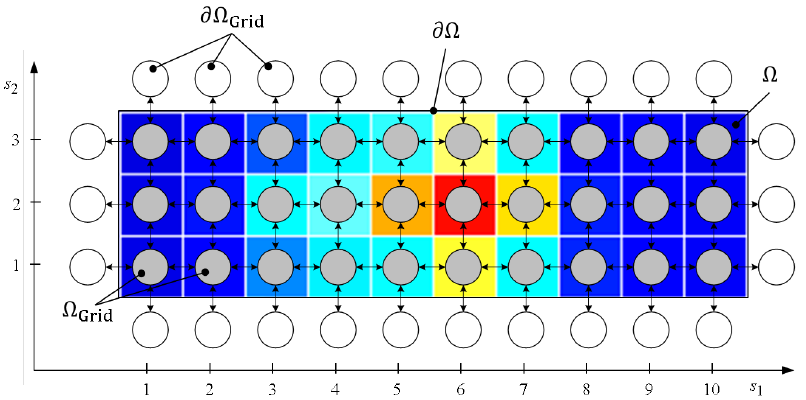
Figure 9. Illustration of spatial discretization for one weld